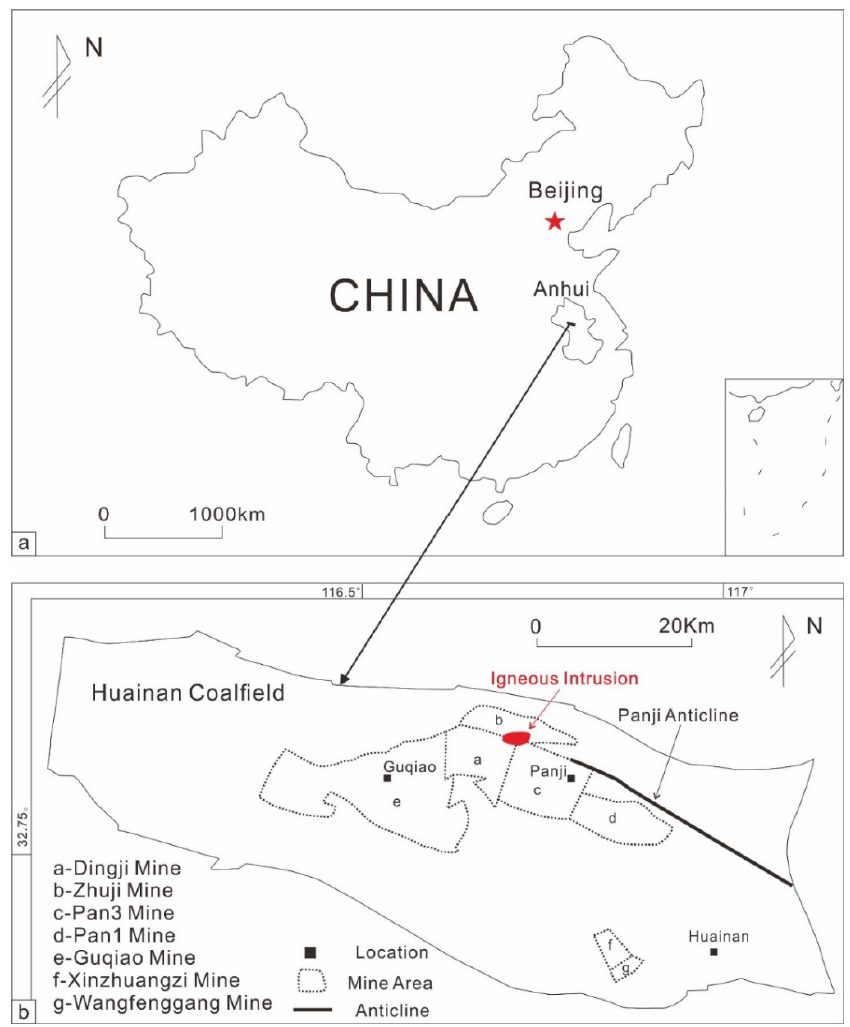
Figure 1. ( a ) Location and ( b ) details in Huainan coalfield (modified from [21–23]).